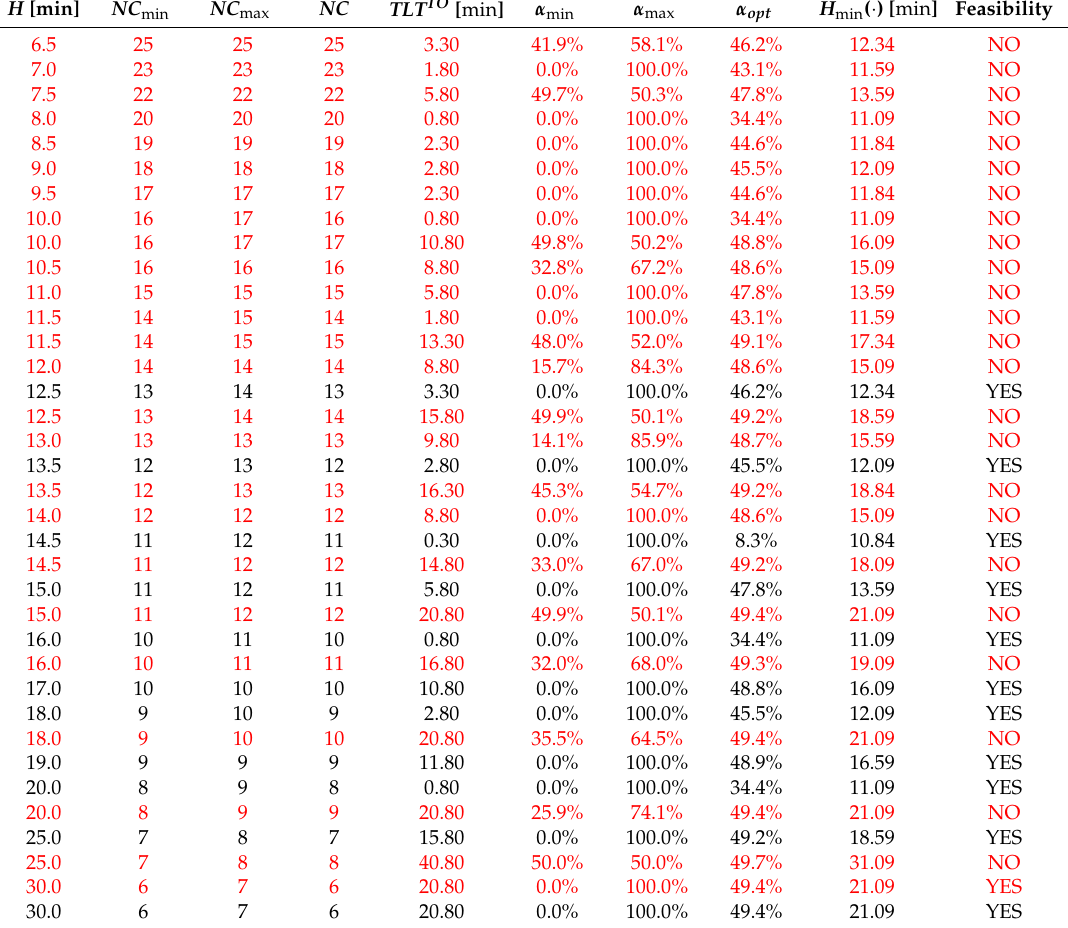
Table 4. Operational schemes in the case of 97.5th percentile (black = feasible configurations; red = unfeasible